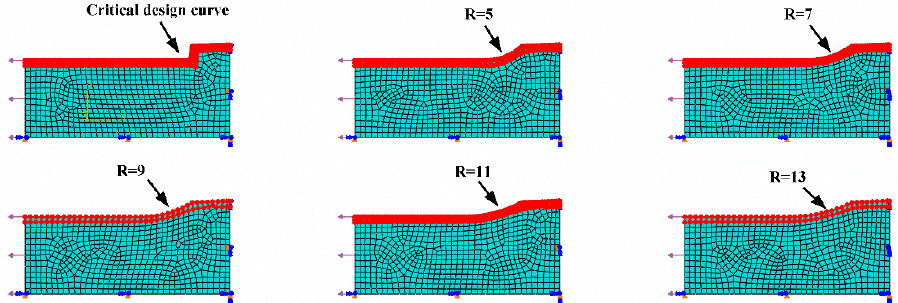
Figure 8. FE models for the geometric optimization of the designed joints.